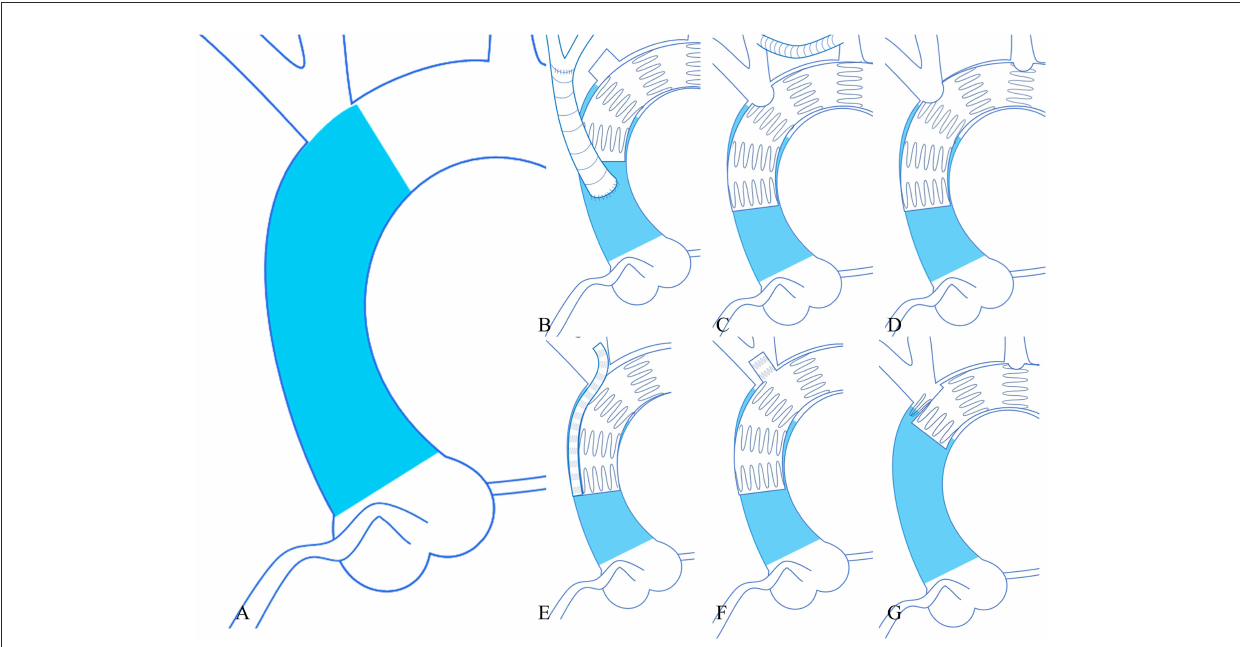
FIGURE2 Six techniques used in zone 0 TEVAR. (A) (Left larger image) the area of zone 0 (blue). (B) (Upper left) TEVAR + debranching procedure. (C) (Upper middle) TEVAR + bypass procedure. (D) (Upper right) fenestrated TEVAR. (E) (Lower left) chimney TEVAR. (F) (Lower middle) branched TEVAR. (G) (Lower right) proximal scalloped and fenestrated TEVAR. TEVAR, thoracic endovascular aortic repair.